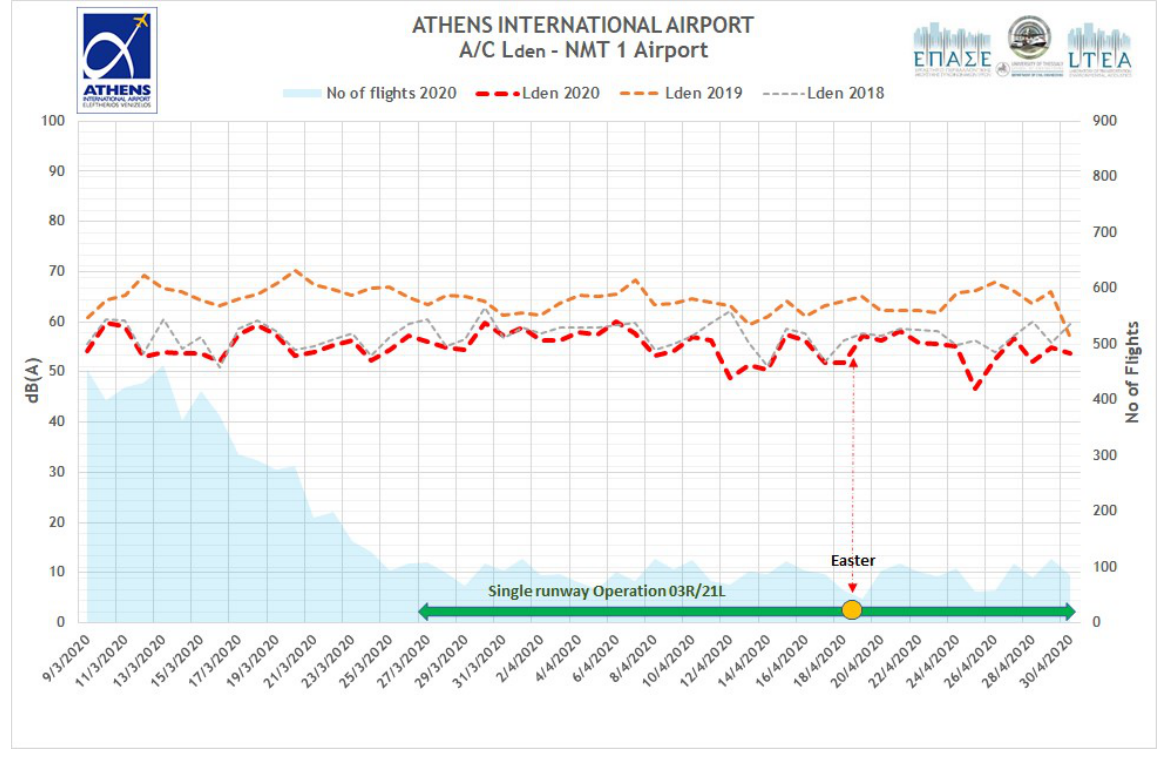
Figure 11a: Fluctuation of L den index – Noise monitoring station NMT 1 (Airport)